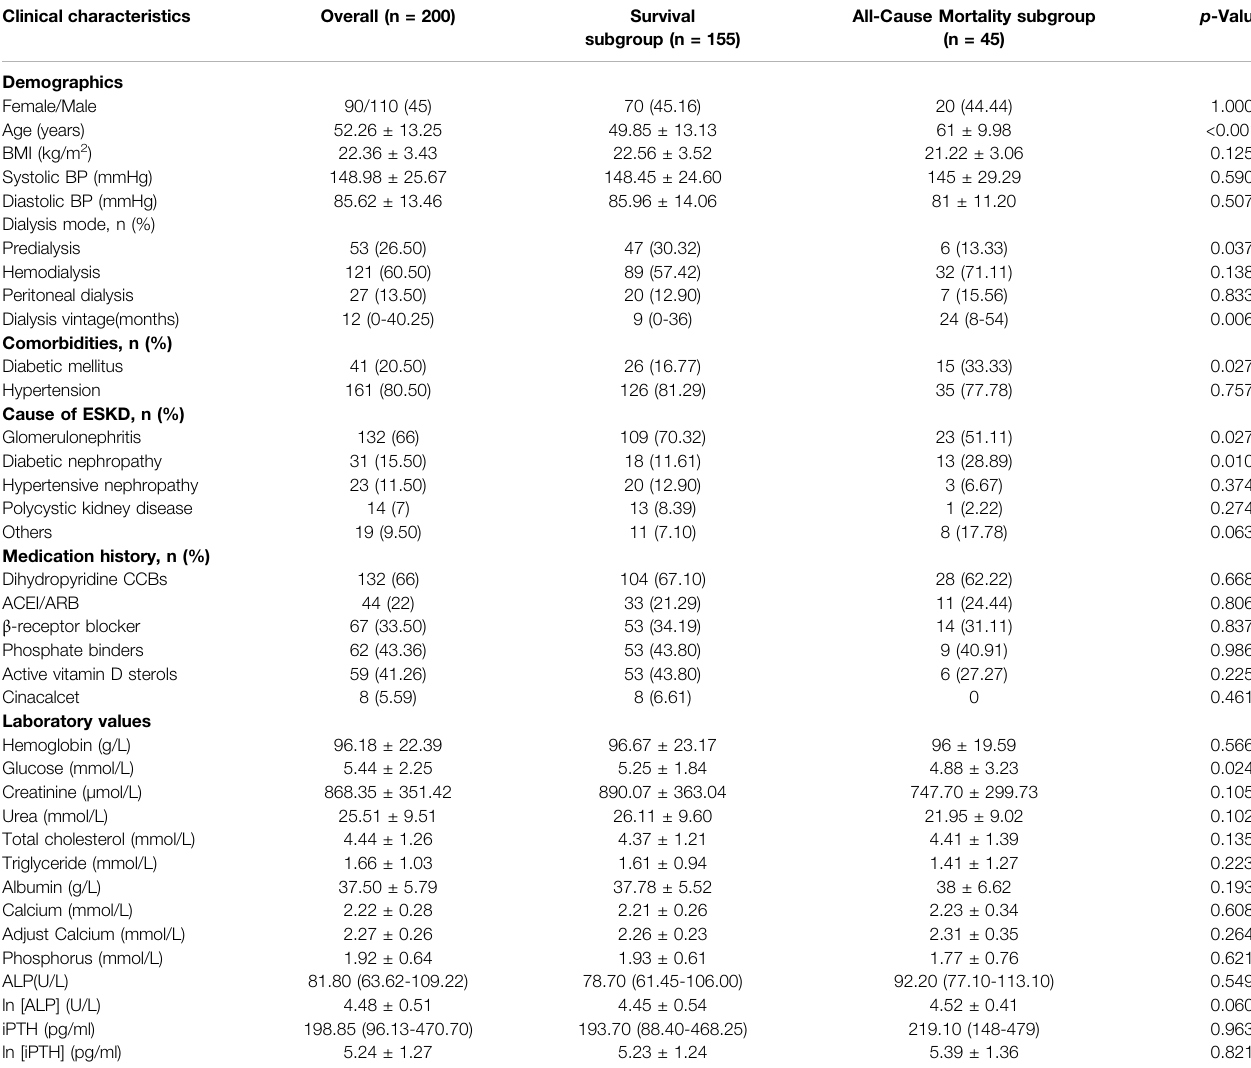
TABLE 1 | Baseline demographics, clinical characteristics and laboratory results in survival and all-cause mortality subgroups of CKD5 patients. Clinical characteristics Overall (n = 200) Survival subgroup (n =